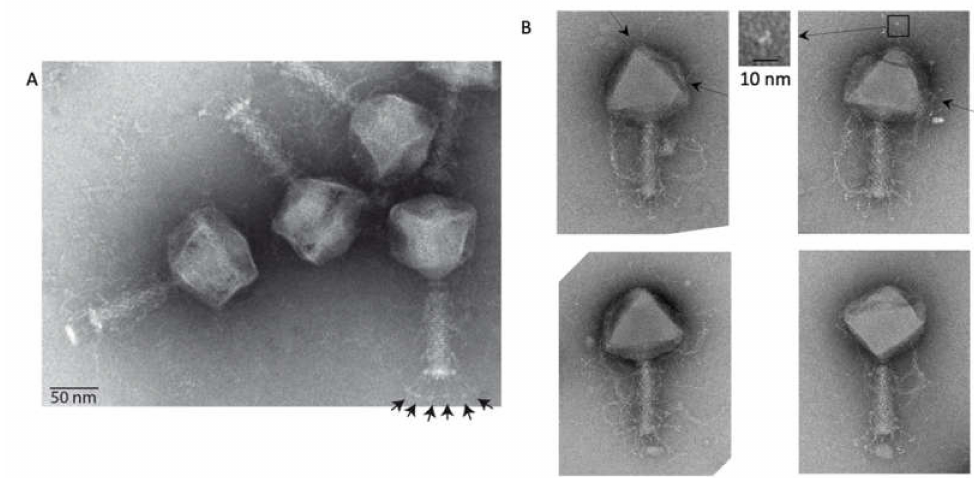
Figure 1. Electron microscopy of phAPEC6. ( A ) Negative staining image of phAPEC6. Six short tail fibers (arrows) on the base plate are clearly visible. ( B ) Di ff erent phAPEC6 particles display hairy appendages, sticking out from the tail but also from the capsid (arrows). Those attached to the capsid seem to be trimers (inset). The scale bar represents 50